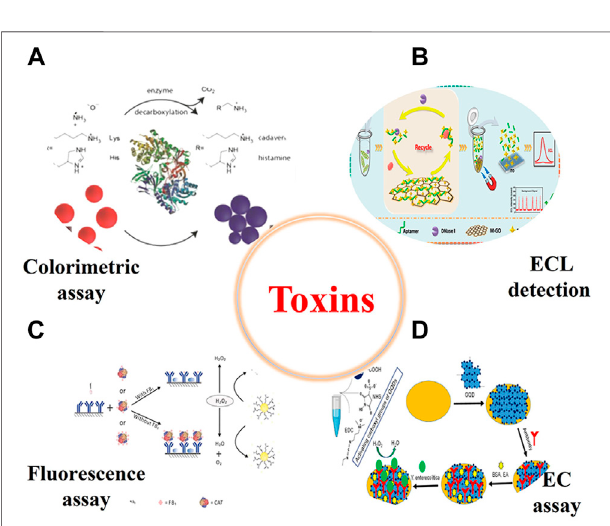
FIGURE 7 | Representative illustration of nanozyme-based method for the detection of all kinds of toxins in food samples (EC, electrochemistry) ( (A) Nilam et al., 2017; (B) Yang et al., 2021; (C) Lu et al., 2018; (D) Savas and Altintas 2019).